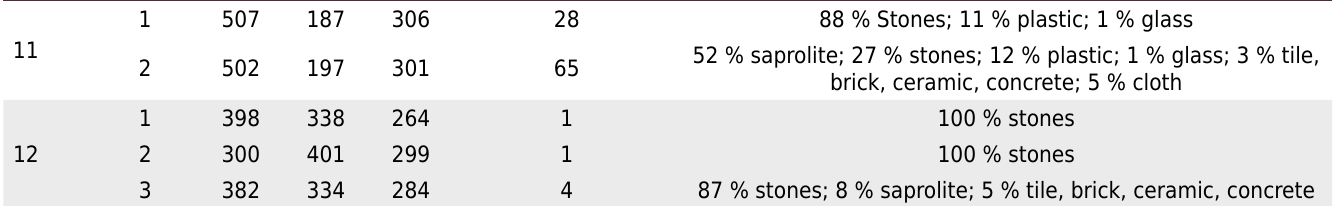
Table 5. Descriptive statistics of the physical data for the urban soils of Santa Maria, Rio Grande do Sul State, Brazil Soil properties (1)